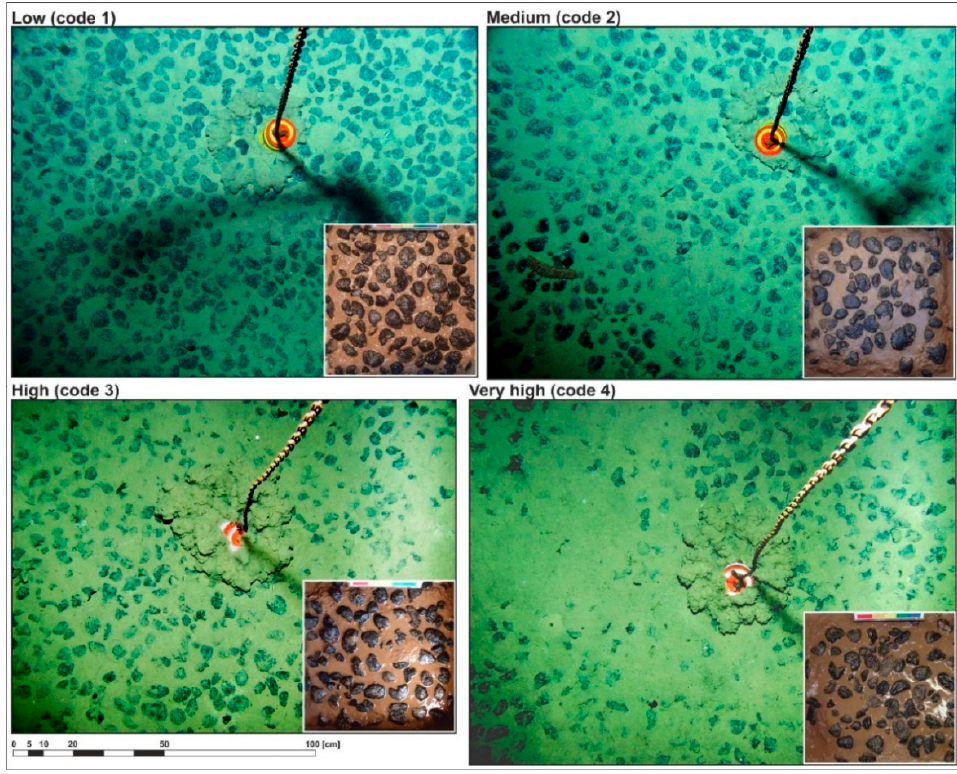
Figure 4. Examples of photographs (seafloor and box corer) from the H22 exploration block showing different levels of sediment coverage of the nodules; the values (codes) of the ordinal variables are given in parentheses.